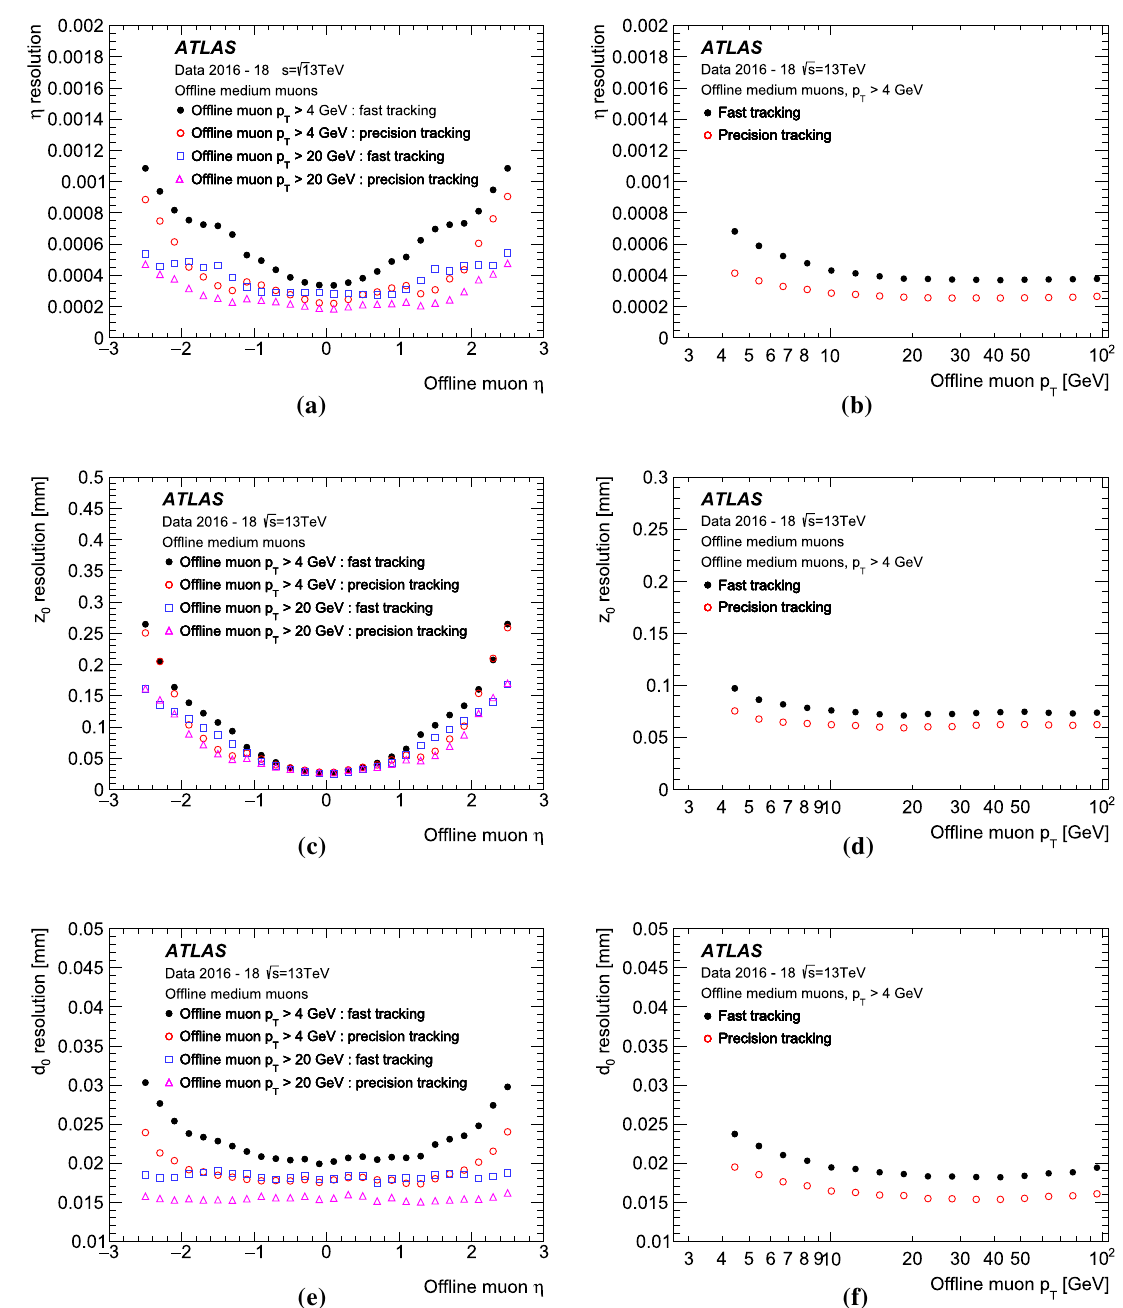
tum. The resolutions are shown for muons selected by the 4GeV and 20GeV muon support triggers for both the fast tracking and